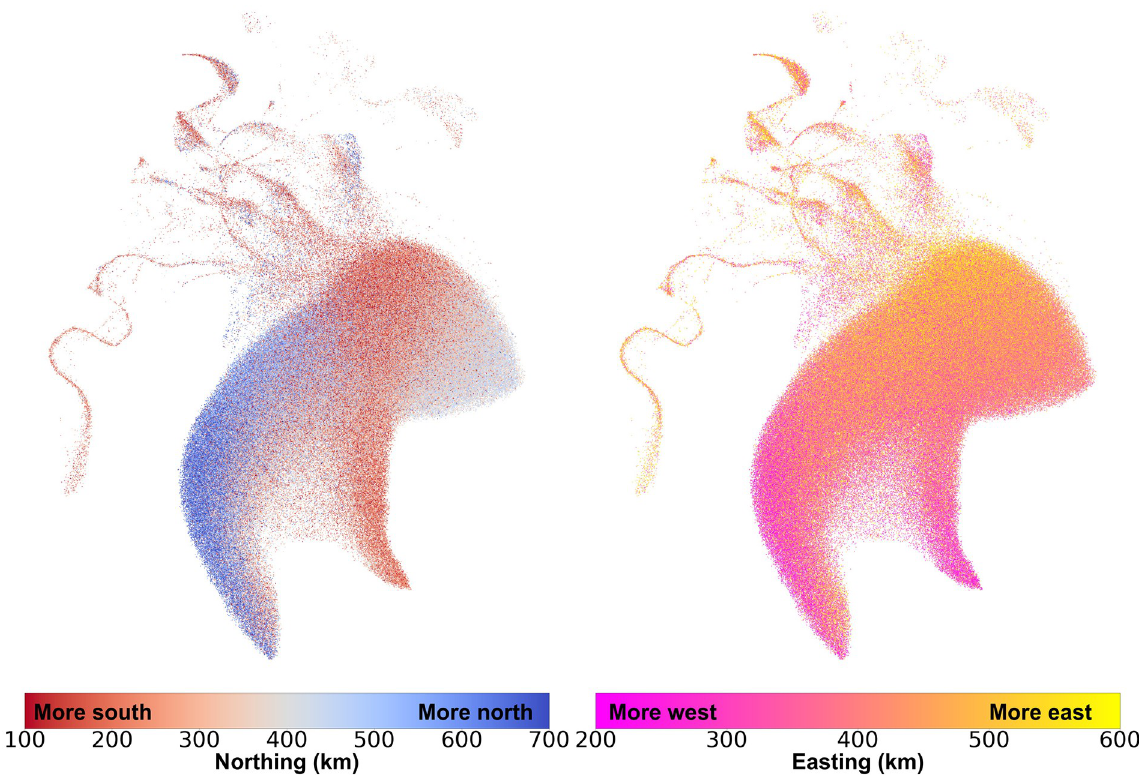
Fig 4. UMAP captures relationships between population structure and geography. Each individual is coloured by their geographical coordinates of residence. Coordinates follow the UKBB’s OSGB1936 geographic grid system and represent distance from the Isles of Scilly, which lie southwest of Great Britain. The left image colours individuals by their north-south (“northing”) coordinates, and the right image colours them by their east-west (“easting”) coordinates. Adding more components creates finer clusters (S17 and S18 Figs). Northing values were truncated between 100km and 700km, and easting values were truncated between 200km and